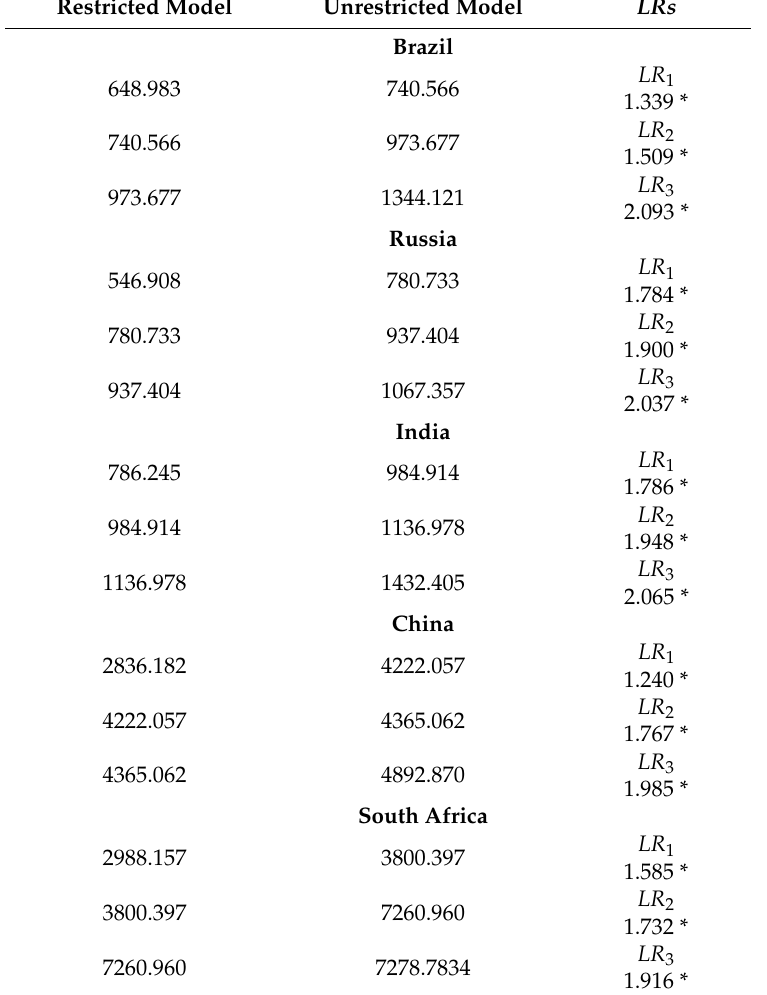
Table 5. Bottom-up